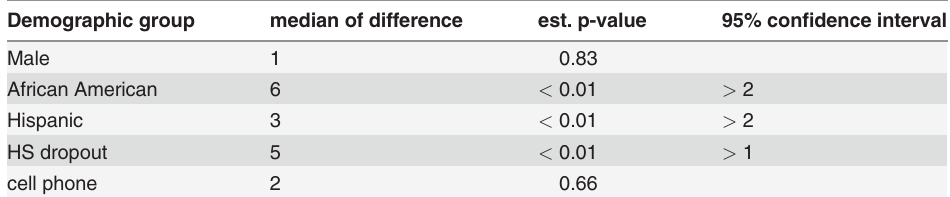
Table 1. Spending levels by various demographic groups. The 95% con fi dence interval is the smallest median of difference one could fi nd to produce a p-value of